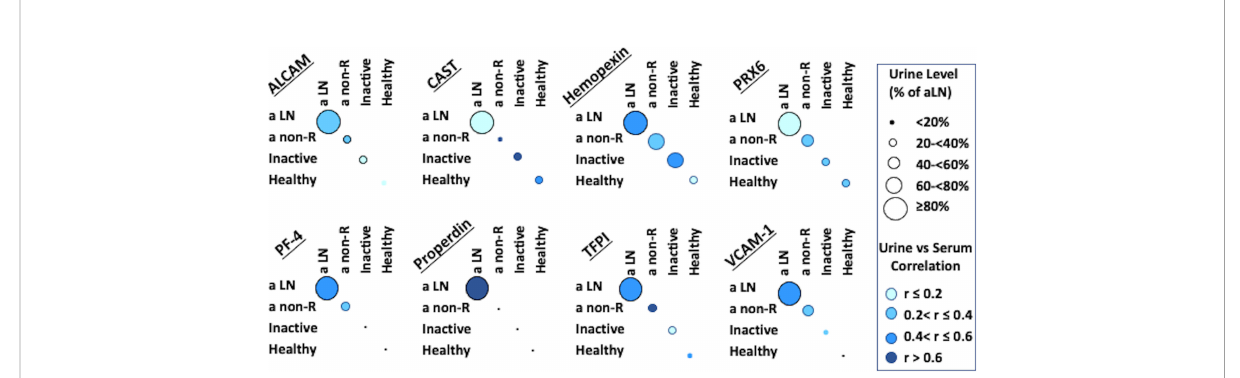
FIGURE 2 Correlation of Serum and Urine protein biomarkers in SLE patients and controls. For each subject, the corresponding values of the protein in urine and serum were considered, in order to ascertain any correlation between these 2 measures. Intensity of blue color represents the strength of serum/urine correlations in each of the 4 subject groups examined, while the size of the circles represents urine biomarker level in each group compared to the level in the active LN group; in all cases the biomarker level in active LN was set to be 100%, corresponding to the maximal circle size.